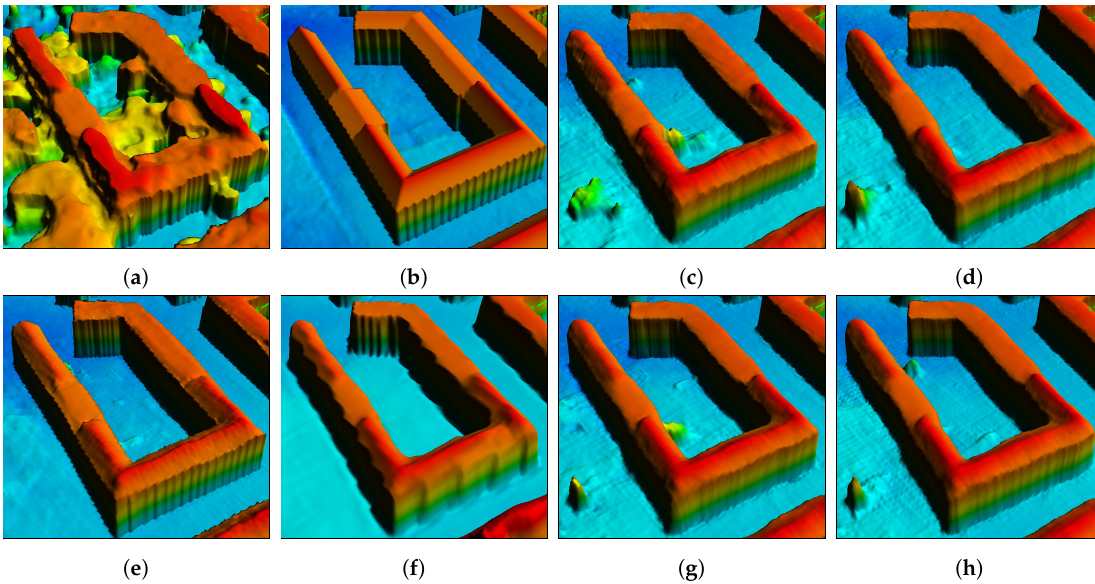
Figure 7. Comparison of the generalization over DSMs from ( c ) the one-stream generator network for a single task [43], ( d ) the one-stream generator based on the UNet network for multiple tasks, ( e ) the one-stream generator based on the ResNet34 network for multiple tasks, ( f ) the one-stream generator based on the DeepLabv3+ network for multiple tasks, ( g ) the two-stream generator network jointly trained UNet and ResNet34 architectures for multiple tasks, and ( h ) the two-stream generator network jointly trained UNet and DeepLabv3+ architectures for multiple tasks. ( a ) illustrates the input photogrammetric DSM, and ( b ) demonstrates the ground truth